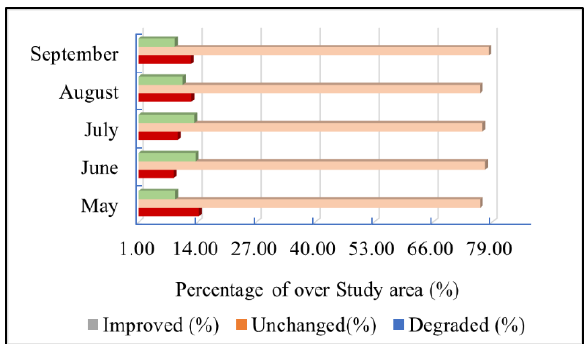
Figure 7. The percentage of hotspot area in over Mongolia from 2000 to 2016 by monthly growing